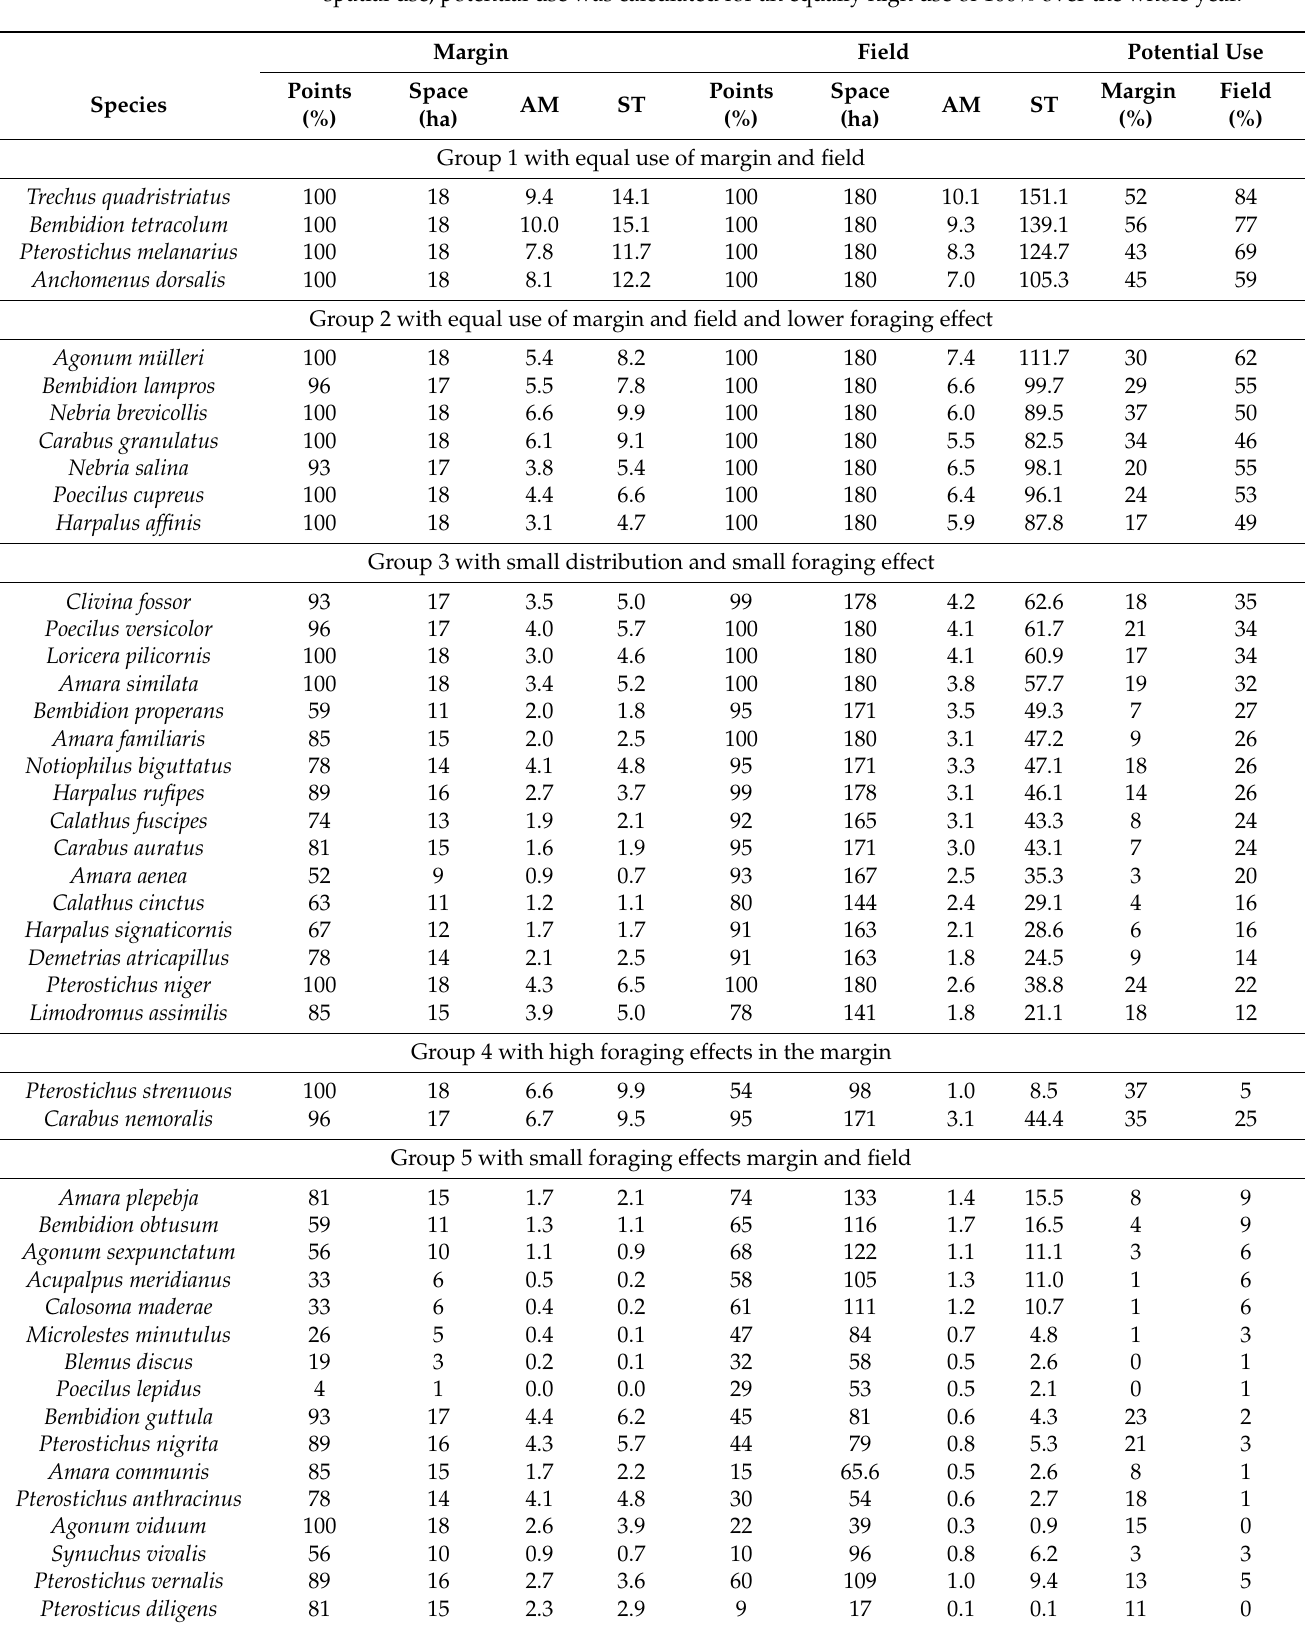
Table 2. Values to estimate the effect of spatial and temporal use by the selected species. AM: part of space with activity of the total available space for margin or field; ST: equivalent for temporal and spatial use; potential use was calculated for an equally high use of 100% over the whole